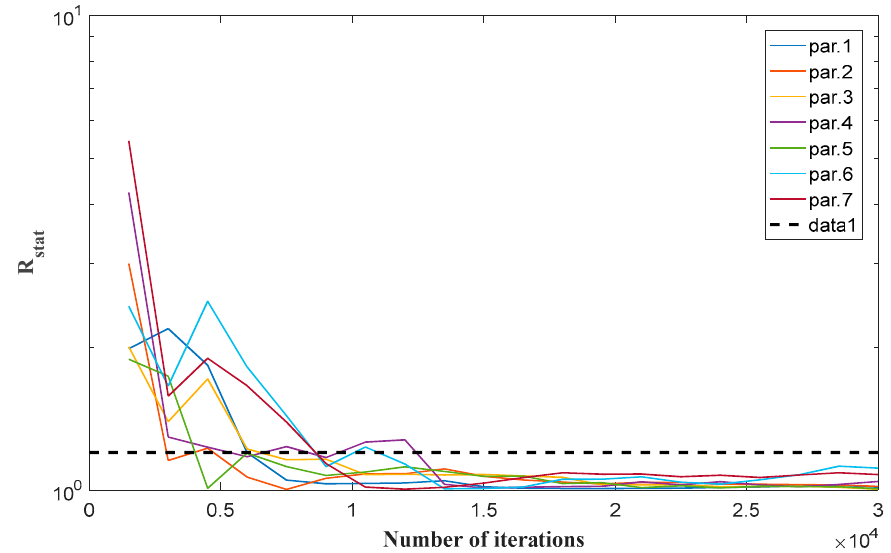
Figure 4. Convergence of the unsaturated soil parameters for linear transport: Variation of the Gelman–Rubin ( R stat ) with the number of iterations. The convergence is achieved if the chains reach the threshold in broken-line ( R stat ≤ 1.2).